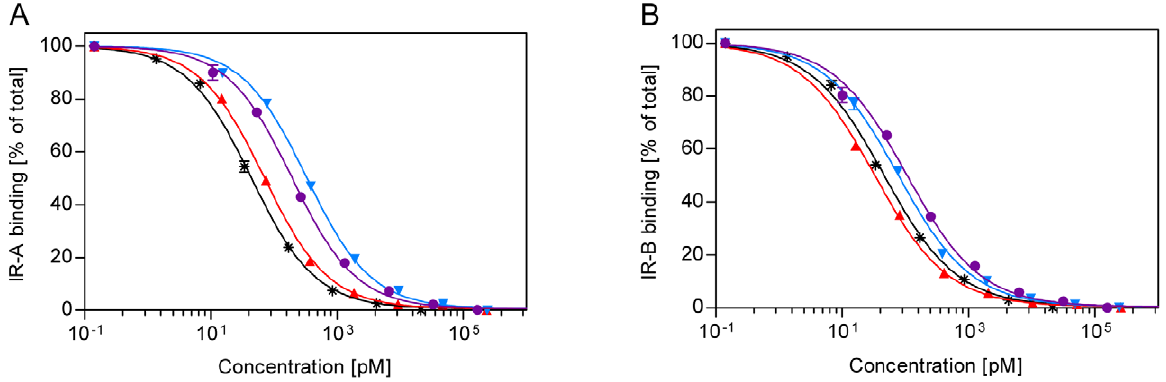
Figure 1. Representative IR competition binding curves. Displacement of 125 I-labelled insulin by human insulin and insulin analogues from the ( A ) A-isoform or the ( B ) B-isoform of the IR. The amount of bound 125 I-labelled insulin as a percentage of bound 125 I-labelled insulin in the absence of unlabelled analogue is plotted against the concentration of unlabelled analogue. Data points are means 6 SEM of four measurements within one assay (n=1). The 125 I-labelled insulin was displaced with purified human insulin standard ( * ) or insulin analogues [A8H, B25H, B27E] ( m ), [A8H, B25N, N ). B27E] ( . ), and [A8H, B25N] (